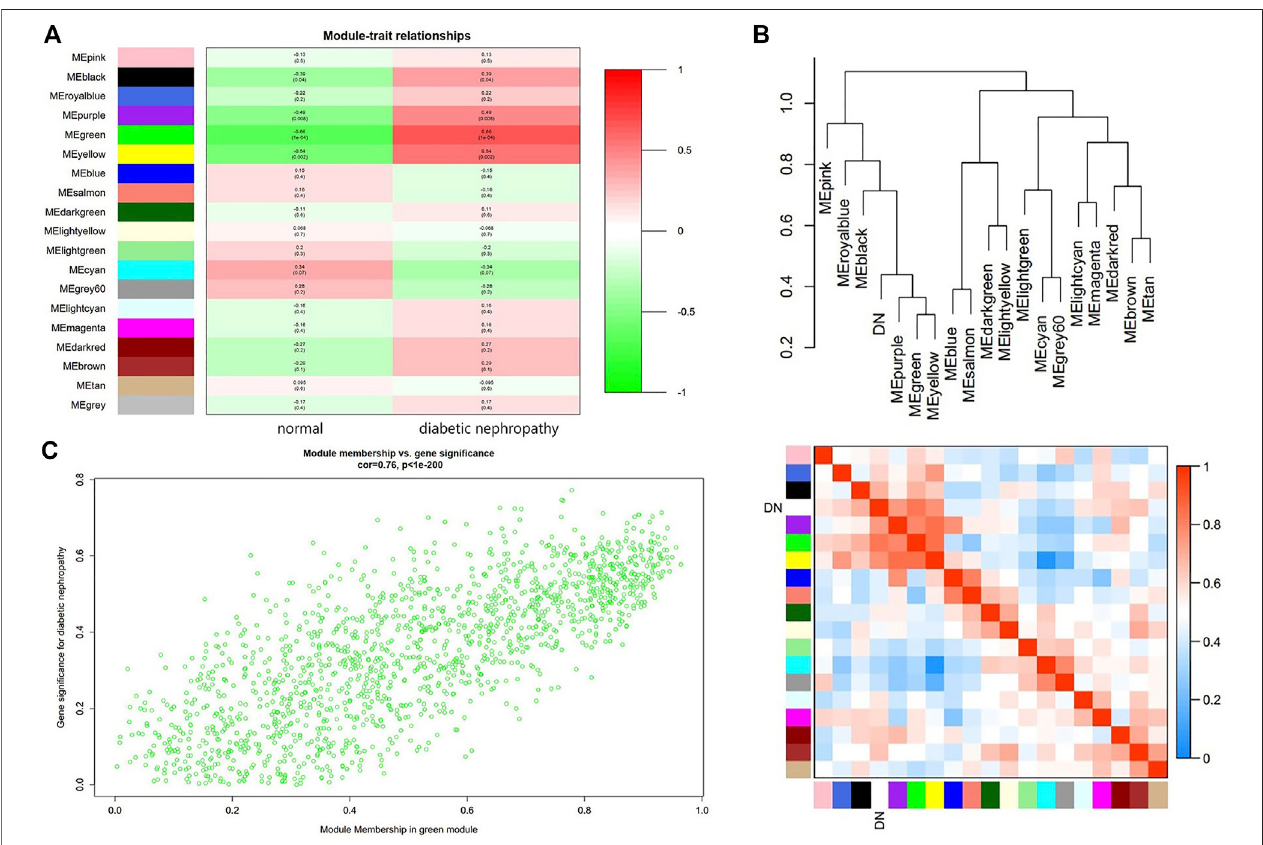
FIGURE3| Main fi ndingsinthemodule-traitcorrelationsanalyses. (A) Module-traitrelationships.Eachrowrepresentsacolormoduleandeverycolumnrepresents a clinical trait (normal and diabetic nephropathy). Each cell contains the correlation coef fi cient and corresponding p value. (B) Cluster diagram of modules (Above) and heatmap of trait and modules (Below) . (C) The gene signi fi cance for diabetic nephropathy in the green module (One dot represents one gene in the green module.).